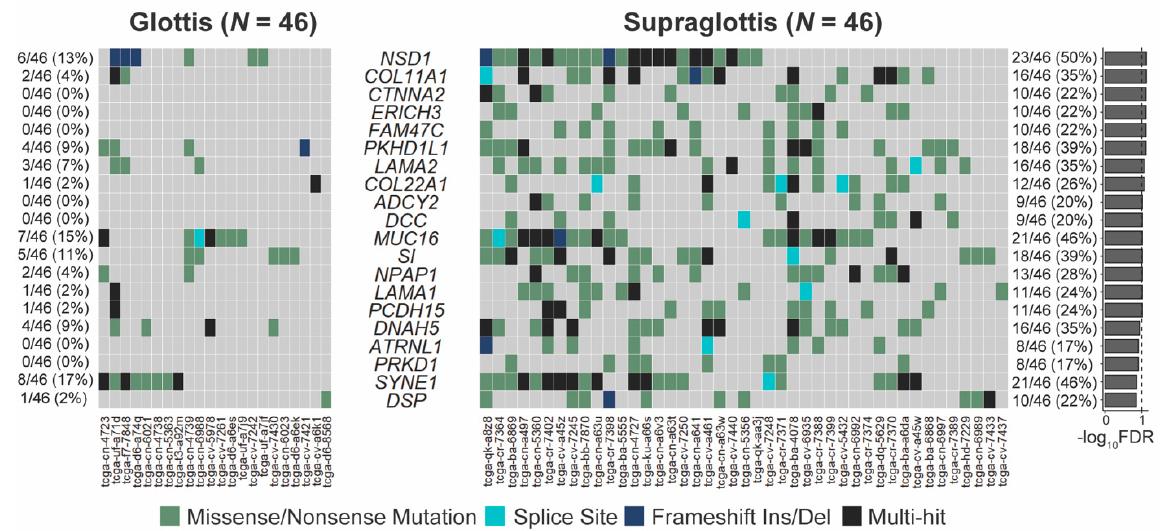
Figure 2. Genes with differing SNV mutation frequencies between supraglottic and glottic LSCC by total SNV mutational load. FDR = false discovery rate.